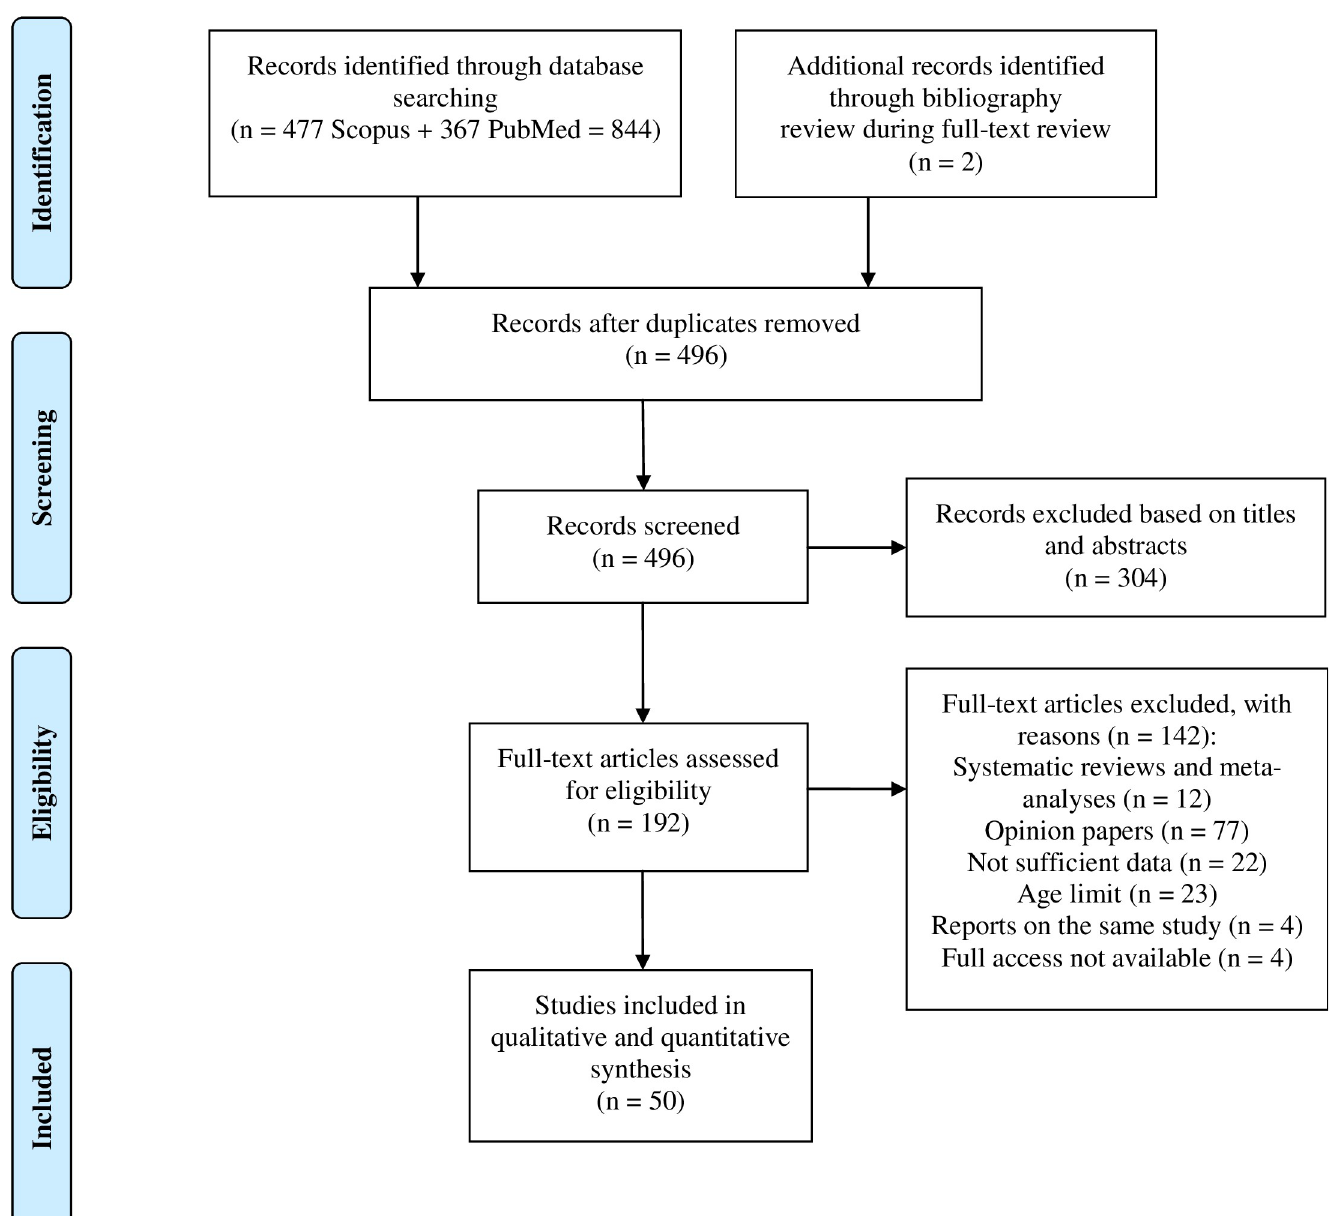
Fig 1. Study flow diagram. A PRISMA flow diagram that details the inclusion and exclusion of studies considered for this systematic review. PRISMA, Preferred Reporting Items for Systematic Reviews and Meta-Analyses. For ideal total cholesterol (Fig 2F), the observed proportions ranged from 0.22 to 0.86, and the estimated pooled proportion based on the random-effects model was ^ m ¼ 0 : 55 (95% CI: 0.51 to 0.59). The observed proportions for ideal fasting blood glucose (Fig 2G) ranged from 0.14 to 0.97, and the estimated pooled proportion based on the random-effects model was ^ m ¼ 0 : 68 (95% CI: 0.62 to 0.73).